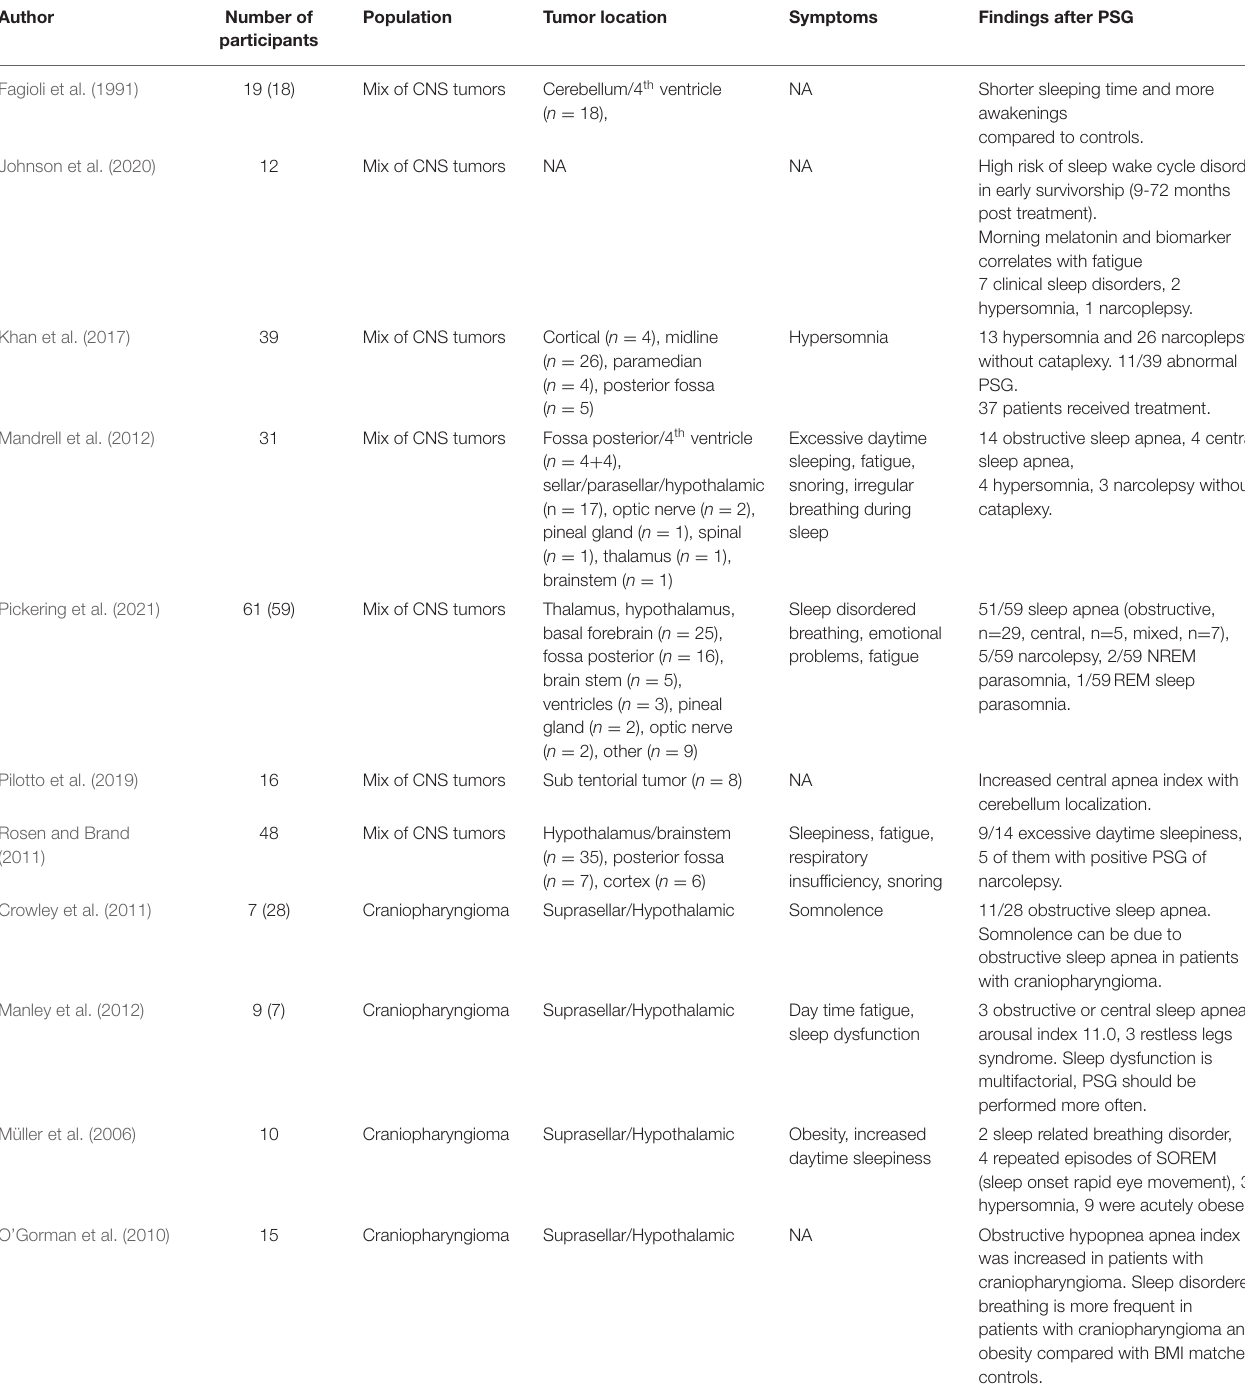
TABLE 3 | Characteristics of population, symptoms leading to polysomnography, tumor location, and findings after